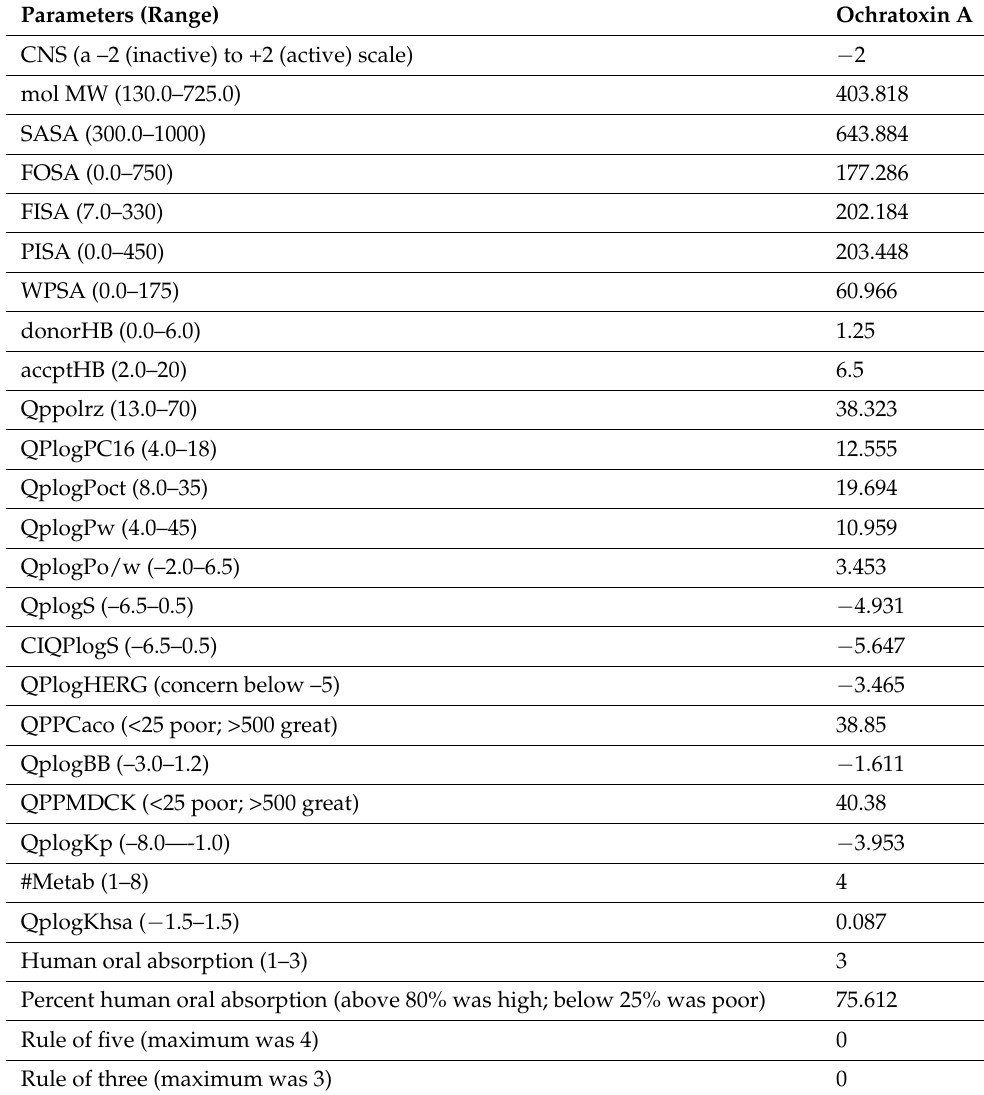
Table 2. The ADMET profiling of ochratoxin A molecule using Qikrop